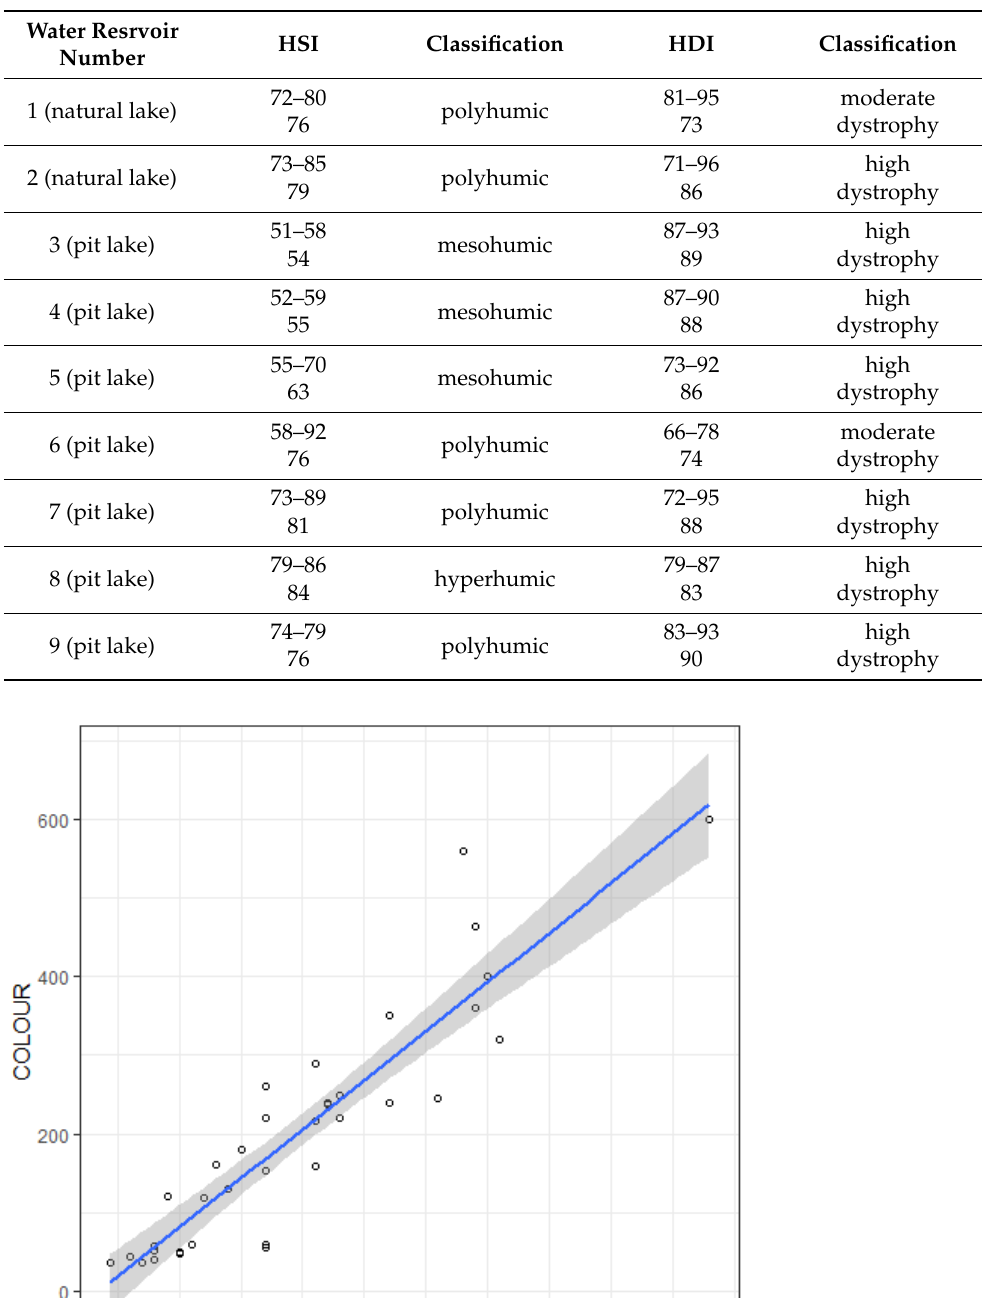
Table 3. Value of HSI and HDI indexes in the water of the studied reservoirs (range, average; n = 5).